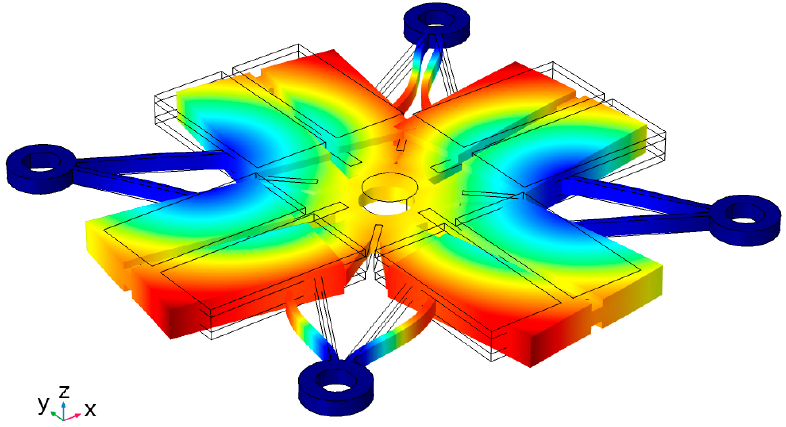
Figure 4. Vibration mode of the motor.